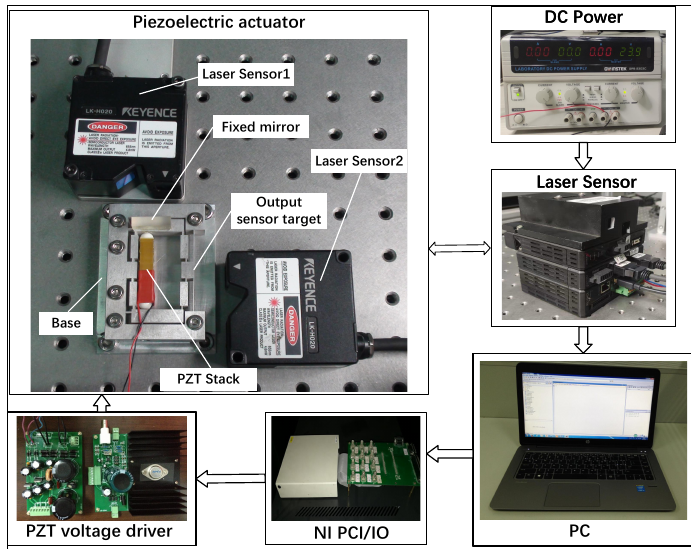
Figure 15. The schematic of the testing experimental